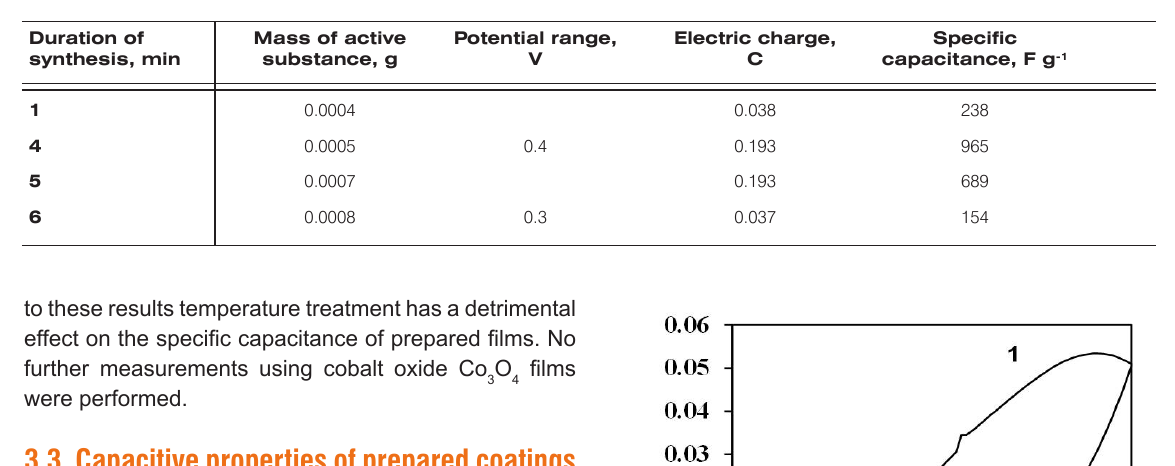
Table 3. Capacitive characteristics of Co(OH)